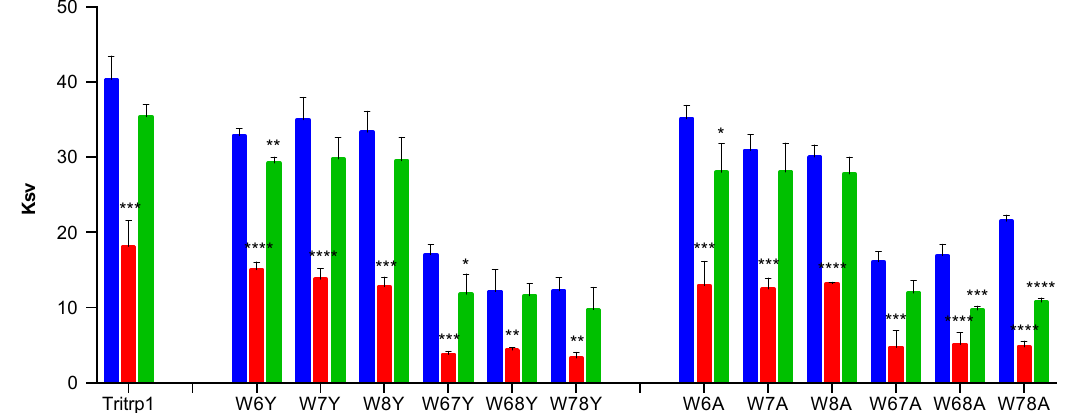
Figure 3. Stern-Volmer constants (Ksv) of the Trp-substituted Tritrp1 analogs as determined by acrylamide quenching experiments in: buffer (blue), ePC:ePG LUVs (red) and ePC:Chol LUVs (green). Results are the mean ± SD ( n =